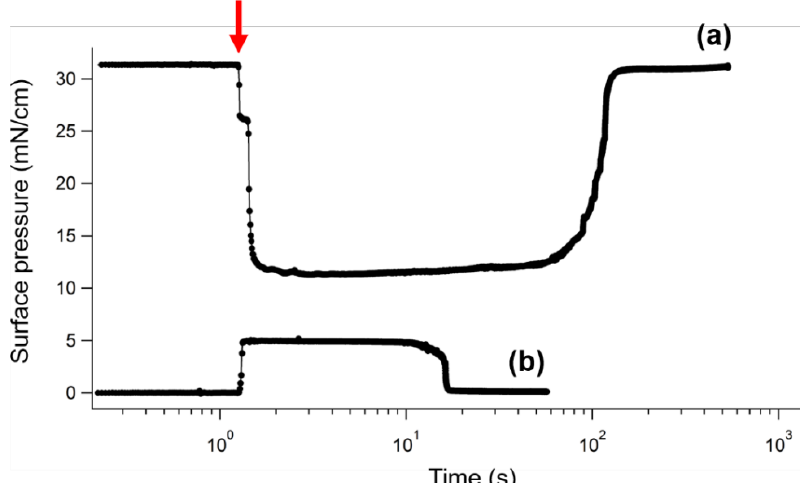
Figure 6. Time profiles of surface pressure on water surfaces ( a ) with the addition of 2.0 × 10 − 9 mol/cm 2 of oleic acid and ( b ) without oleic acid. The red arrow indicates the time at which BT nanocube suspension was dropped onto the water surface.